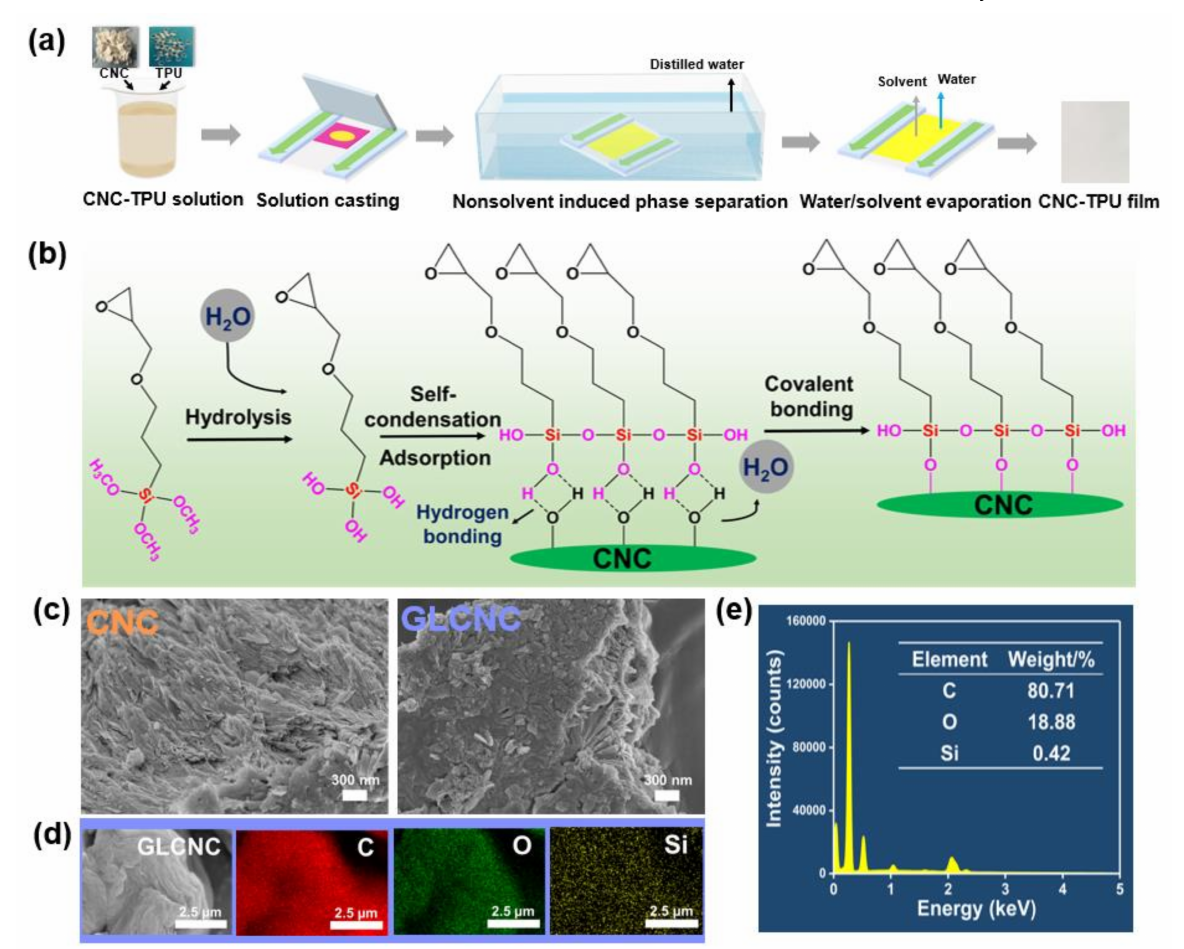
Figure 1. ( a ) Preparation process for CNC/TPU composite films; ( b ) surface modification of CNCs with GL; ( c ) SEM images of CNCs and GLCNCs; ( d ) SEM-EDS mapping images of GLCNCs; ( e ) and EDS spectroscopy of GLCNCs.